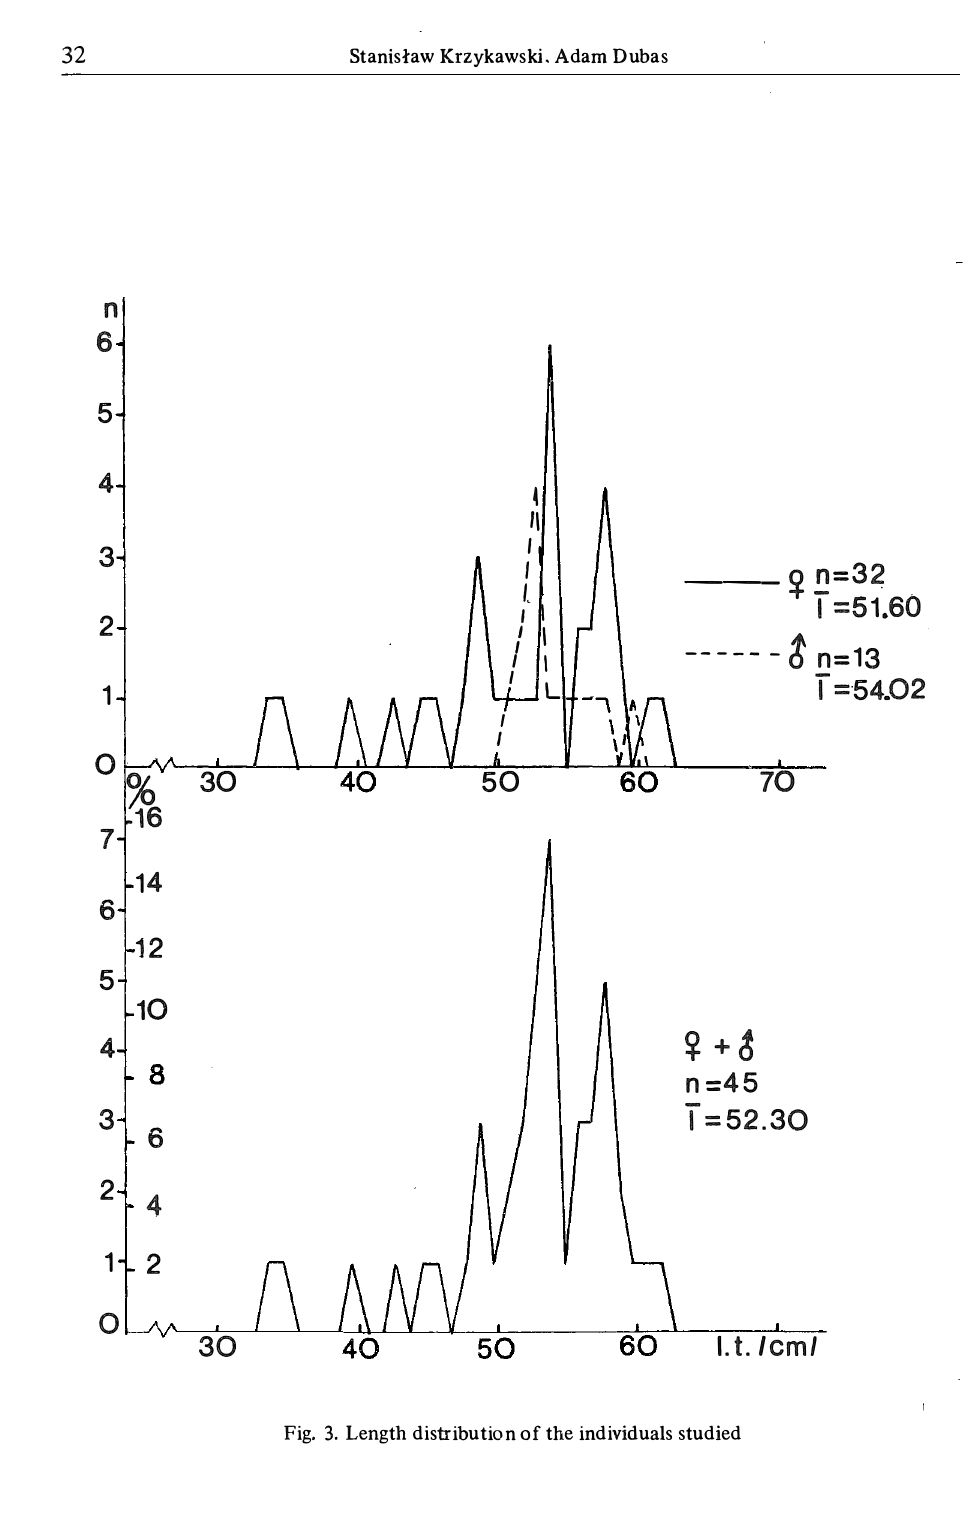
Fig. 3. Length distribution of the individuals